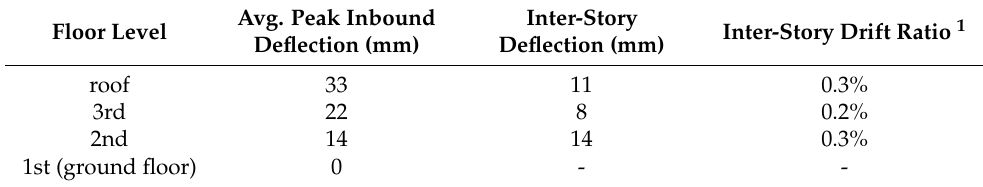
Table 2. Test 1—Average of peak inbound lateral deflections and estimated inter ‐ story drift ratios.